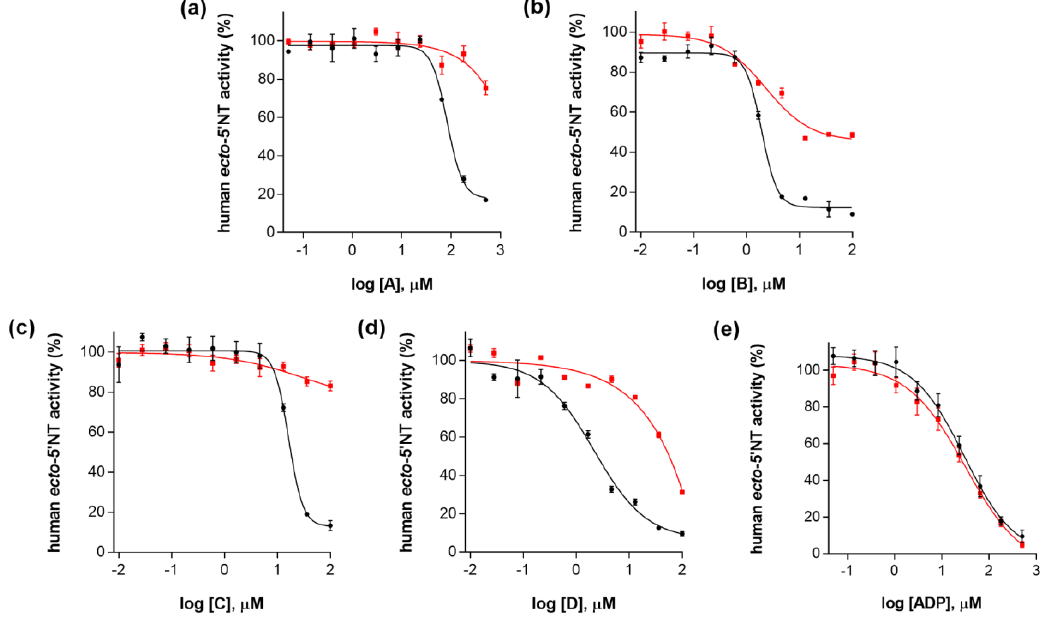
Figure 3. Dose-response curves for ( a ) compound A ; ( b ) compound B ; ( c ) compound C ; ( d ) compound D and ( e ) ADP (negative control), without 0.01% ( v / v ) Triton X-100 (curves in black) and with 0.01% ( v / v ) Triton X-100 (curves in red). All assays were carried out in a reaction mixture containing HEPES buffer (10 mM; pH = 7.4), buffer (10 mM; pH = 7.4), MgCl 2 (2 mM), CaCl 2 (1 mM), human ecto -5 (cid:48) -NT (3.6 nM), AMP (500 µ MgCl 2 (2 mM), CaCl 2 (1 mM), human ecto - 5′ -NT (3.6 nM), AMP (500 µM) as substrate, and tested compound over a range of concentration values (0 – 500 µM for A and ADP; and 0 – 100 µM for B , C and D ), with or without 0.01% ( v / v ) Triton X-100. After incubation for 10 min at 37.0 ± 0.2 °C, the reactions were stopped by heating the